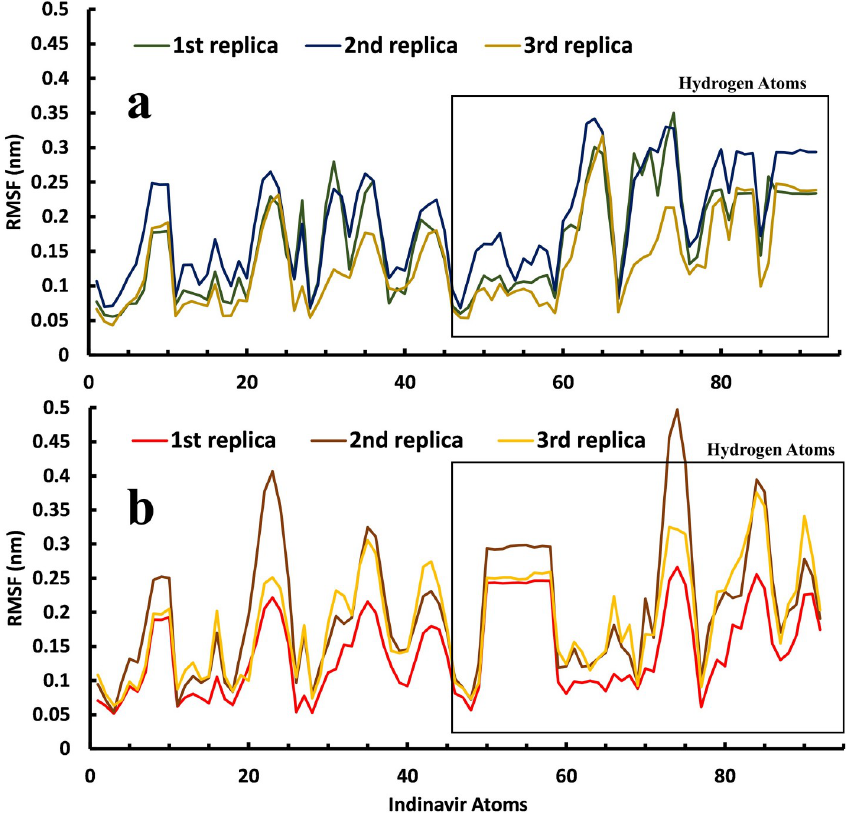
Fig 10. A comparison between the RMSF values of the Indinavir atoms during the three replicas of the unbinding pathways. a, in the active site of the HIV protease and, b, in the active site of the HTLV-1 protease.